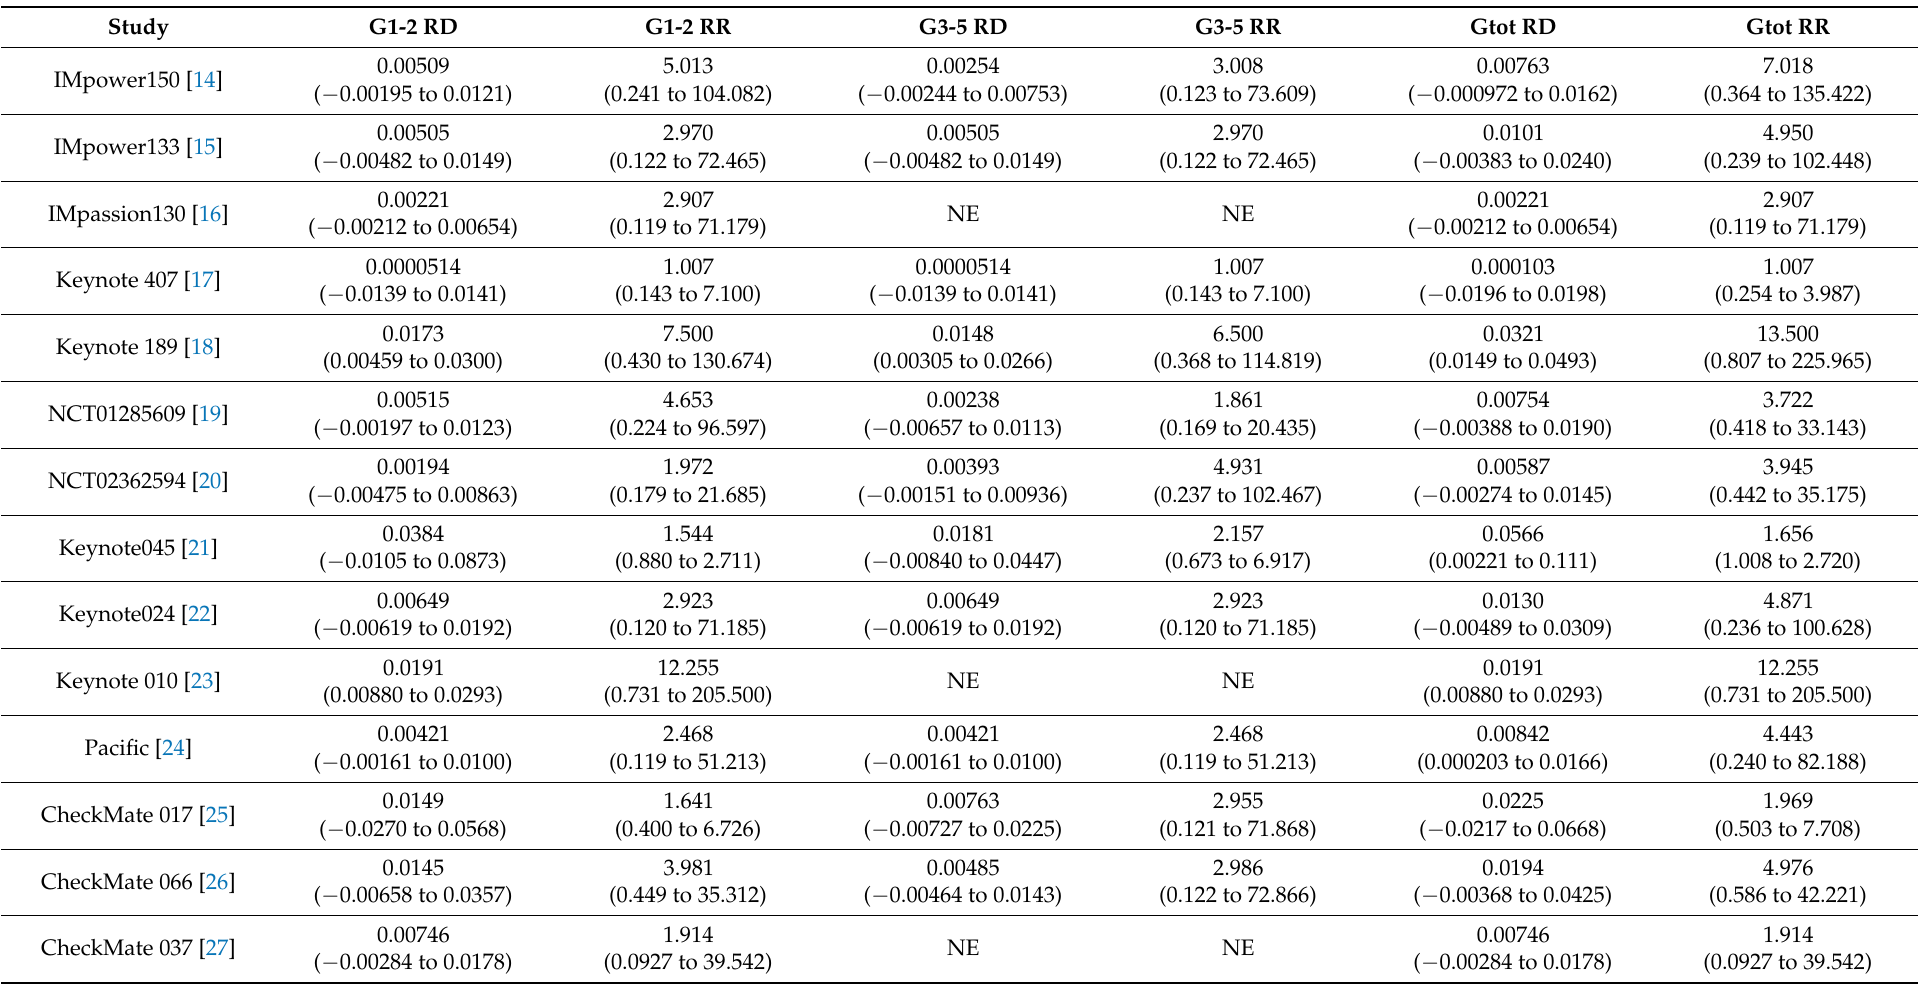
Table 2. Summary of the results of our meta-analysis. We reported RD and RR of each study included with 95% CI. We also reported final results estimated adopting fixed and random model effect of overall population, population receiving ICIs alone, ICIs combination, and CTLA-4 inhibitors. Results were estimated for low-grade toxicity, high-grade toxicity and all-grade